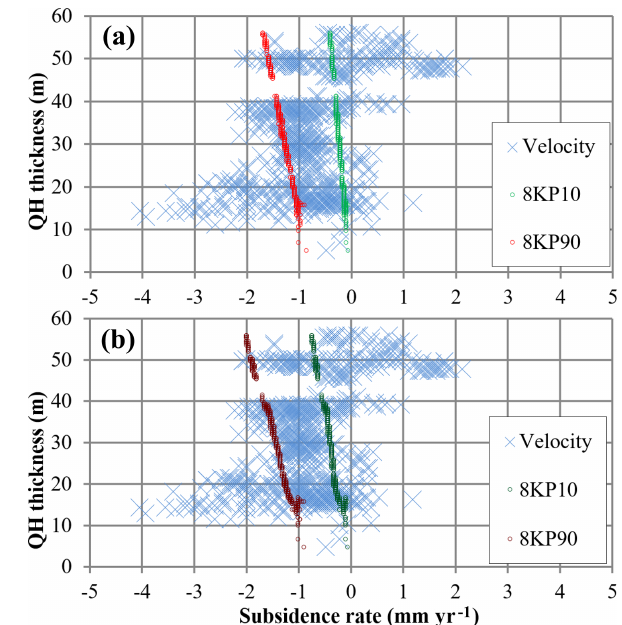
Figure 3. Comparison between subsidence rates on Ebro delta with DInSAR results, considering only the natural compaction (a) and adding the lithospheric efects (b)